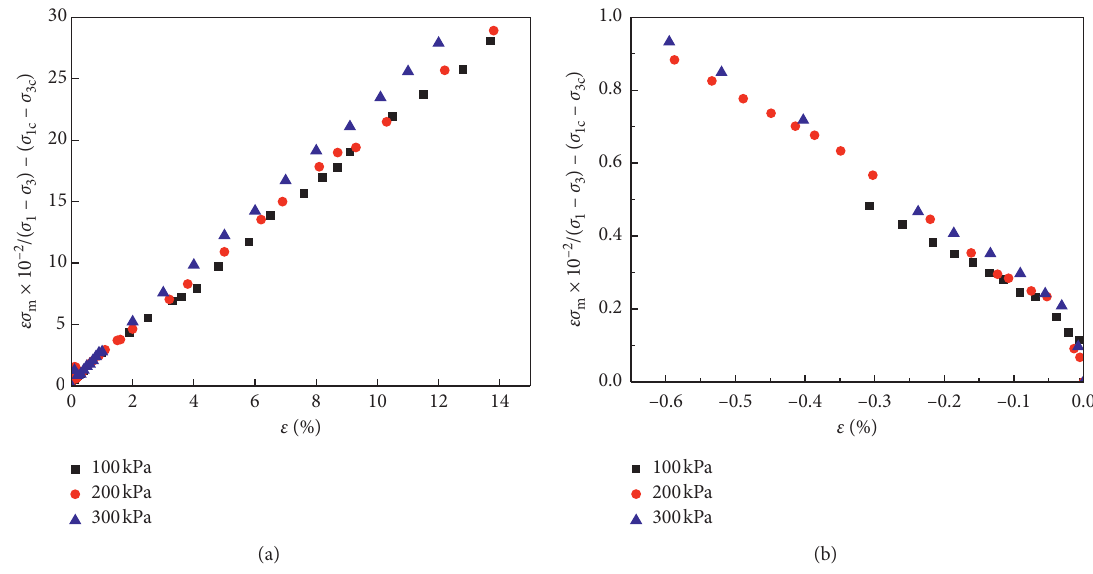
Figure 7: Normalization of deviator stress-strain. (a) Stress path UU0.0. (b) Stress path UU2.0.